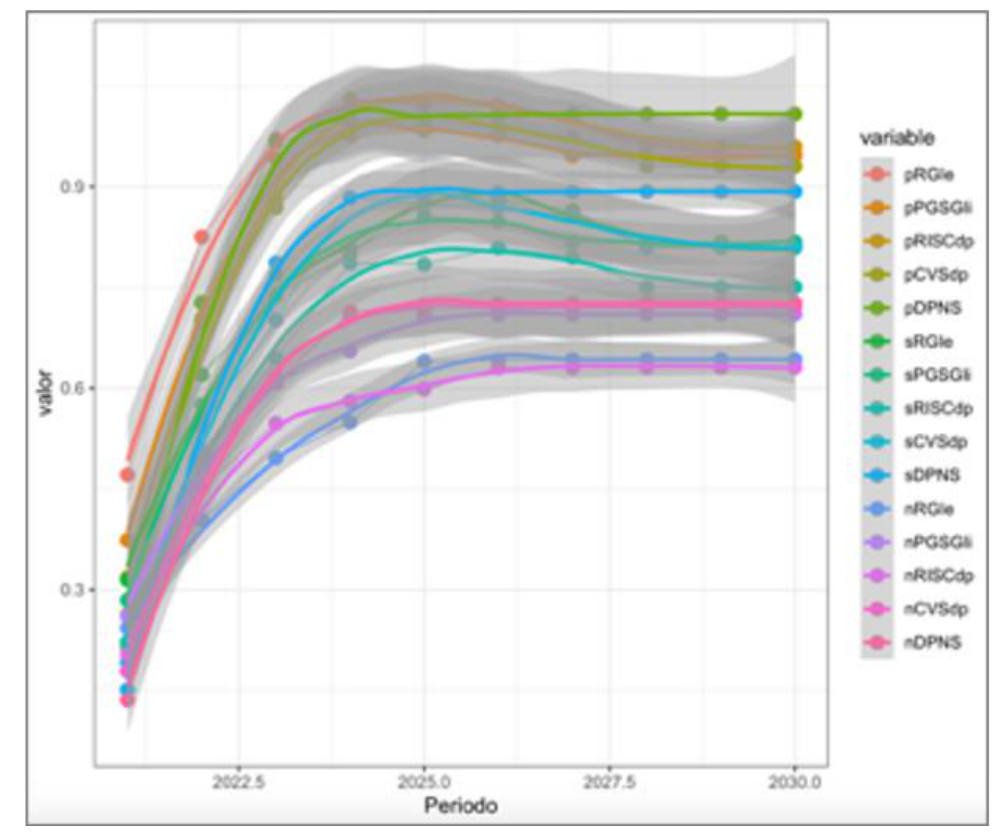
Figure 4. Cone of